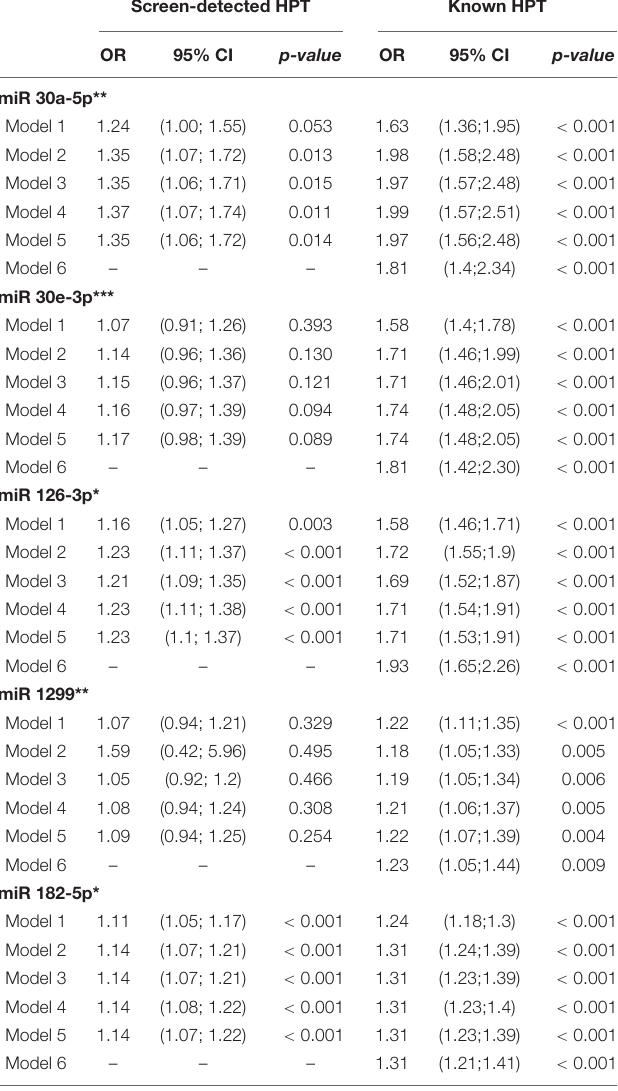
TABLE 3 | Multivariable regression analysis of miRNAs for the presence of screen-detected and known hypertension. Screen-detected HPT Known